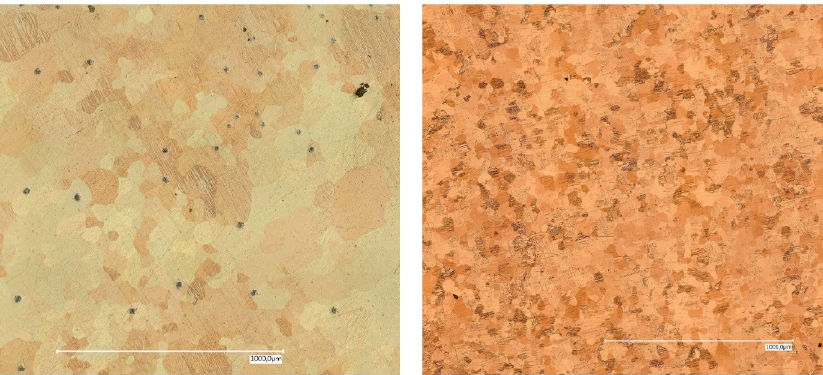
Figure 4. Microscopic appearance of etched surfaces of XHP (left) and cp (right) magnesium. Table 2. Surface roughness.